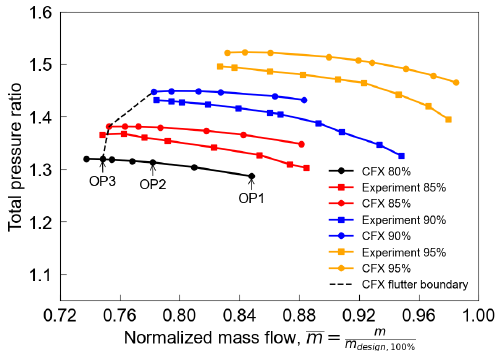
Figure 3. Fan speedlines at 80%, 85%, 90% and 95% rotational speeds.